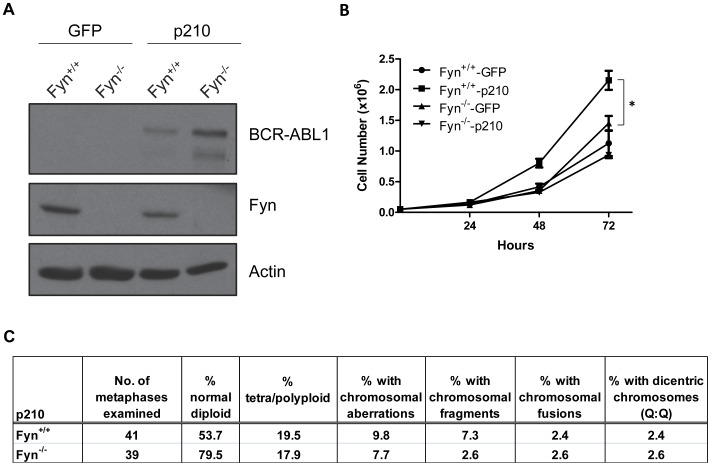
Loss of Fyn decreases the growth of MEFs transduced with BCR-ABL1 and protects against BCR-ABL1 induced genomic instability.(A) Immortalized mouse embryonic fibroblasts (MEFs) derived from Fyn wild-type (Fyn+/+) and Fyn knockout (Fyn−/−) mice were transduced with vector (GFP) or vector expressing p210 BCR-ABL1 (p210). After sorting GFP-positive cells, BCR-ABL1 and Fyn protein expression were monitored in total cell lysate by Western blot using antibodies specific for Abl and Fyn, respectively. Actin was used as a loading control. The blot is representative of three independent experiments. (B) Vector (GFP) and p210 transduced MEFs were plated in 6-well plates and live cells were counted on the days indicated. *p<0.01, n = 3, mean+SEM. (C) Table depicting the various chromosomal abnormalities seen in Fyn+/+ and Fyn−/− MEFs transduced with BCR-ABL1.